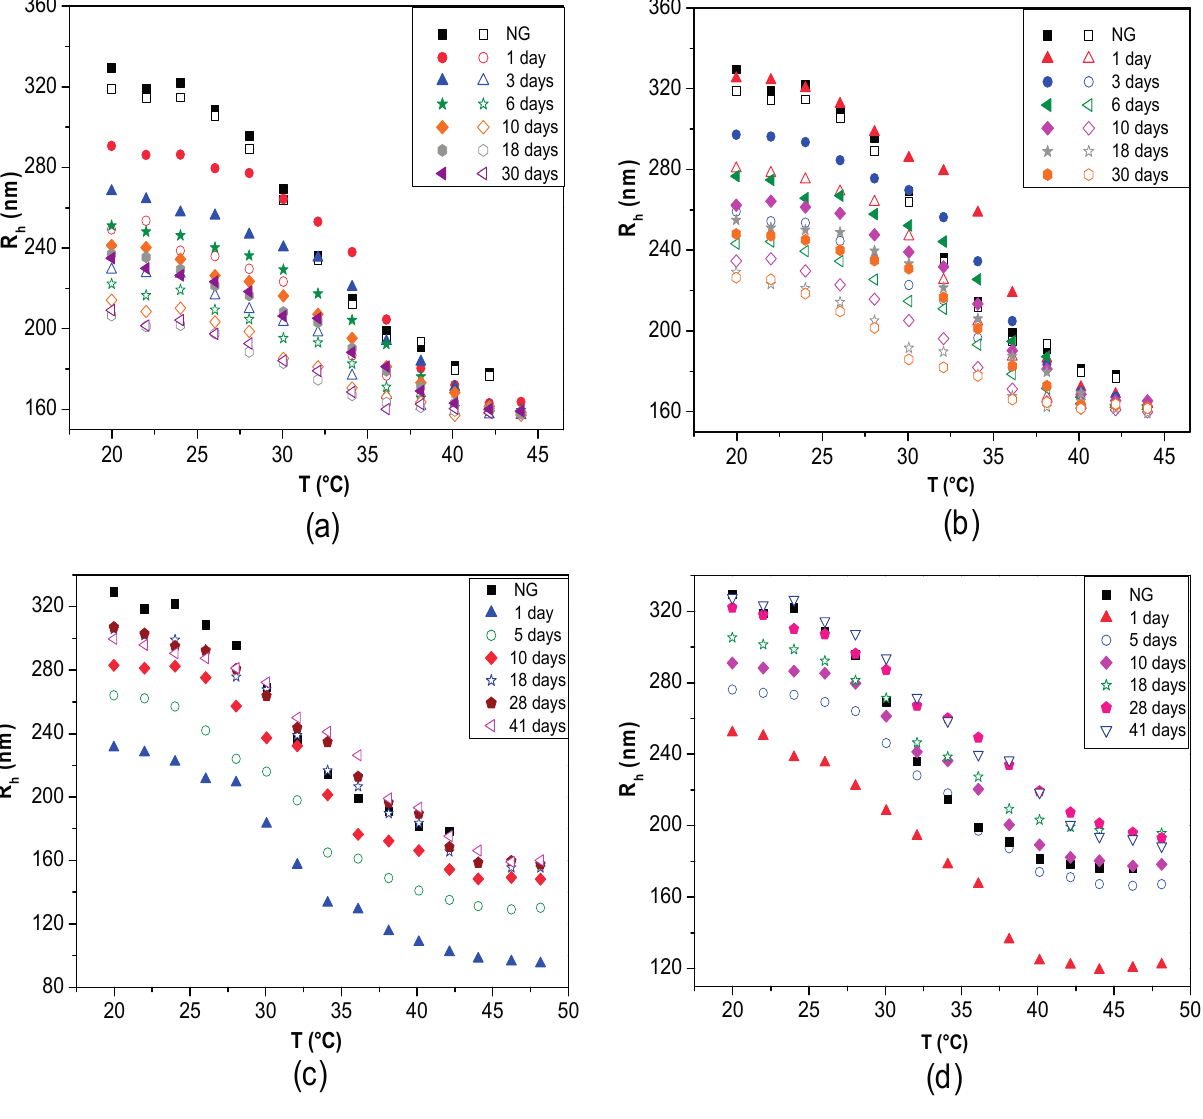
Figure 13. Temporal stability of LbL-coated PNIPAM- co -MMA NGs in water over different periods of time: ( a ) NG/PLL; ( b ) NG/(PLL/PGA); ( c ) NG/CHIT and ( d ) NG/(CHIT/DEXS). Closed and empty symbols correspond to heating and cooling cycles, respectively. Gels coated with polysaccharide layers ( c and d ) are reversibly thermoresponsive; for clarity, only the heating cycles are shown. Reproduced with permission from [8], copyright 2010,